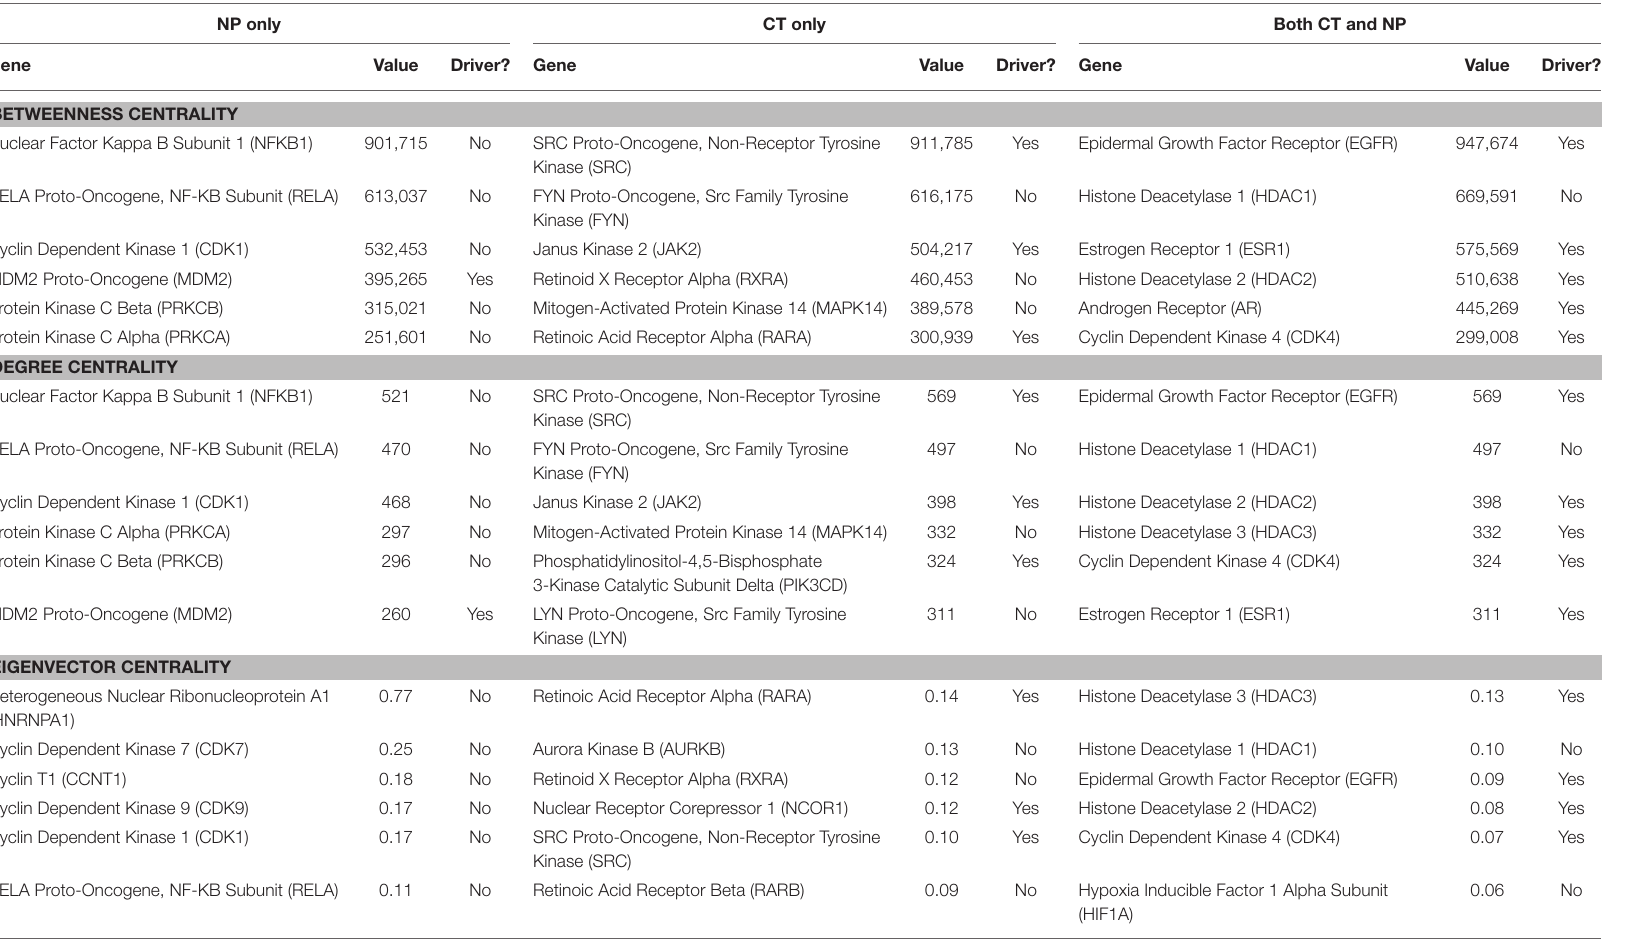
The top 6 genes with the highest values of betweenness, degree and eigenvector centrality are shown for each node category: targeted by NP only, targeted by CT drugs only, or targeted by both NP and CT drug. All interactions are < 100nM binding